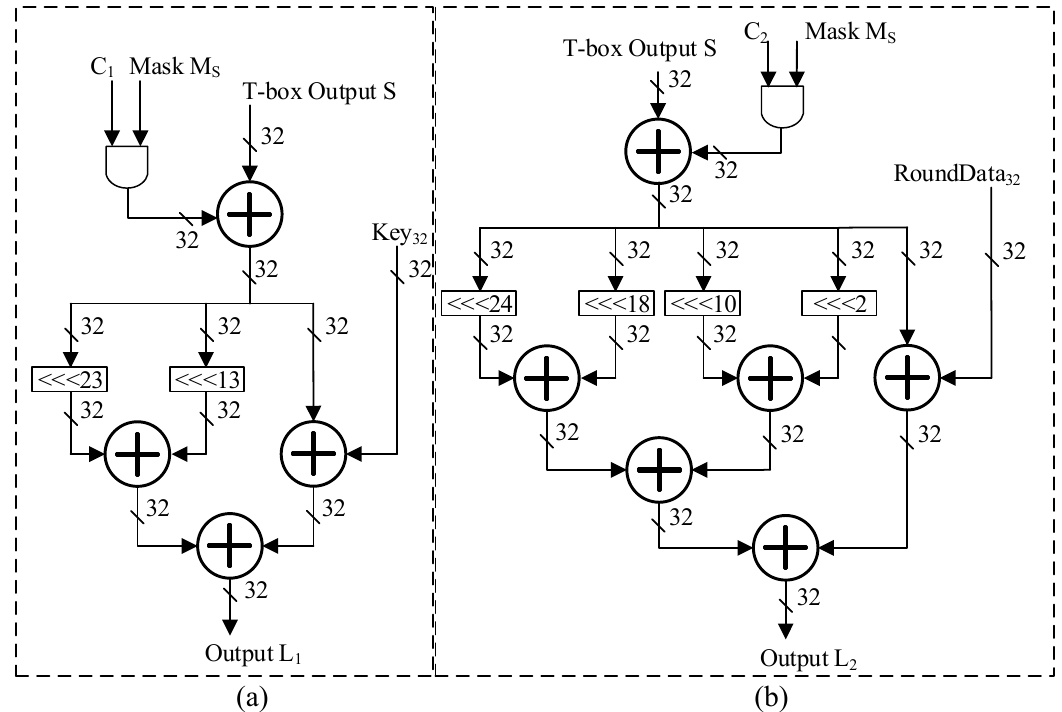
Figure 5. Random linear transformation operation module circuit structure diagram. ( a ) shows the random linear transformation L1 of the key extension, and ( b ) shows the random linear transformation L2 of the round